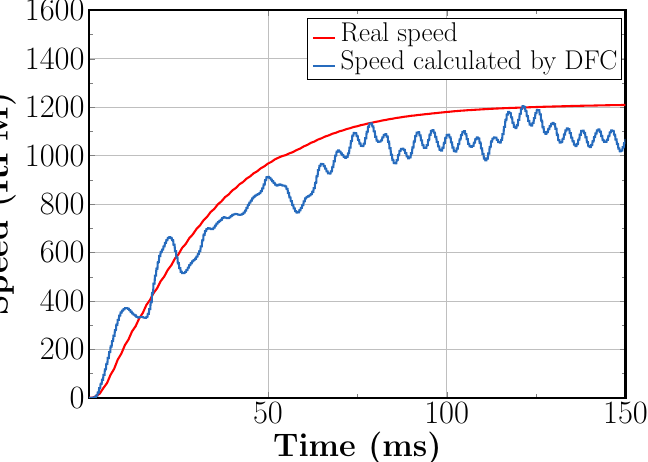
Figure 14. Sensorless speed control for 1200 RPM, real speed of the machine and speed calculated by DFC.